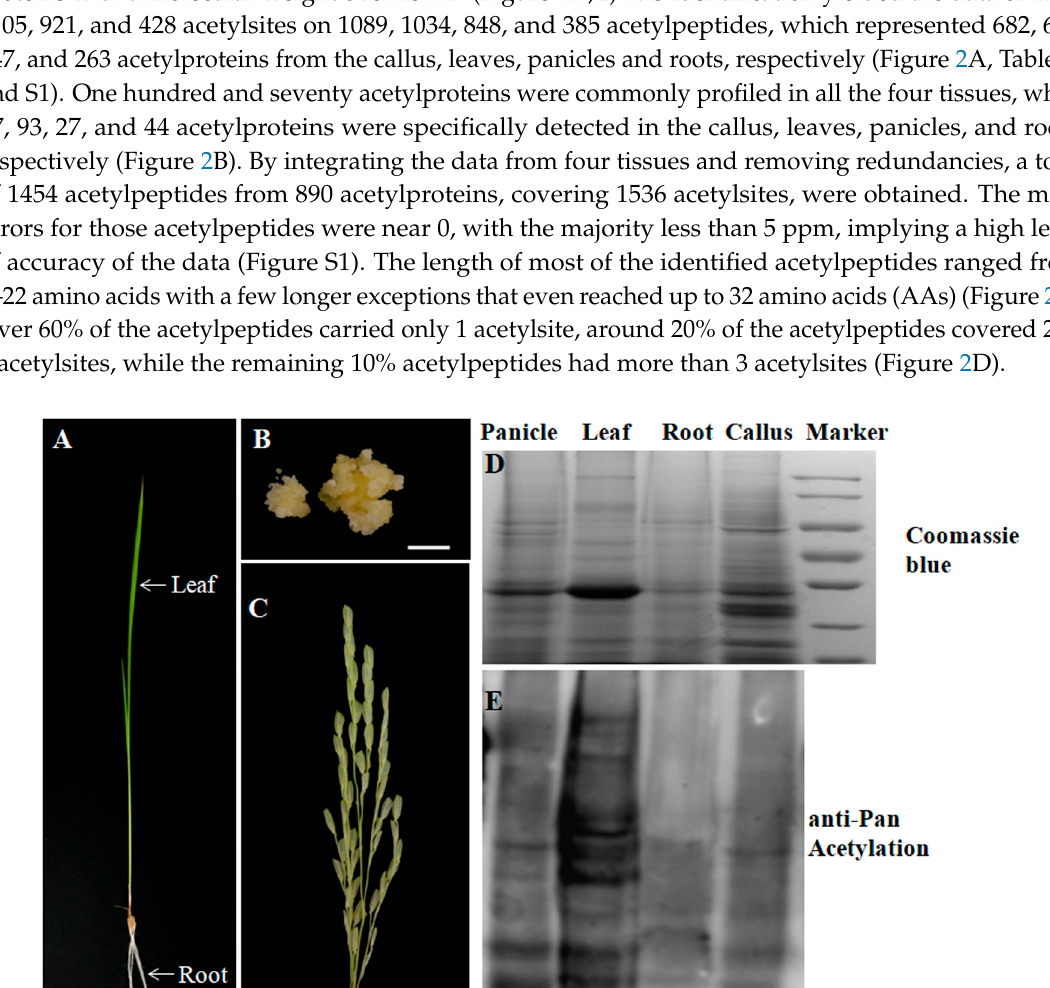
blot analysis on the tissue proteins using a pan anti-acetylation antibody. The protein acetylation levels